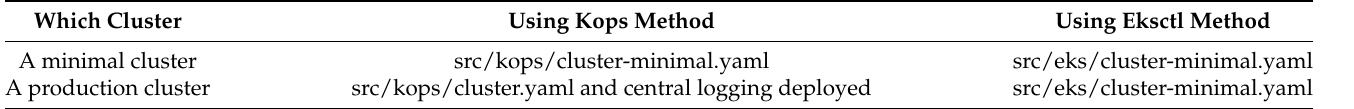
Table 2. Files used to deploy minimal and full clusters using: kops and eksctl. Which Cluster A minimal